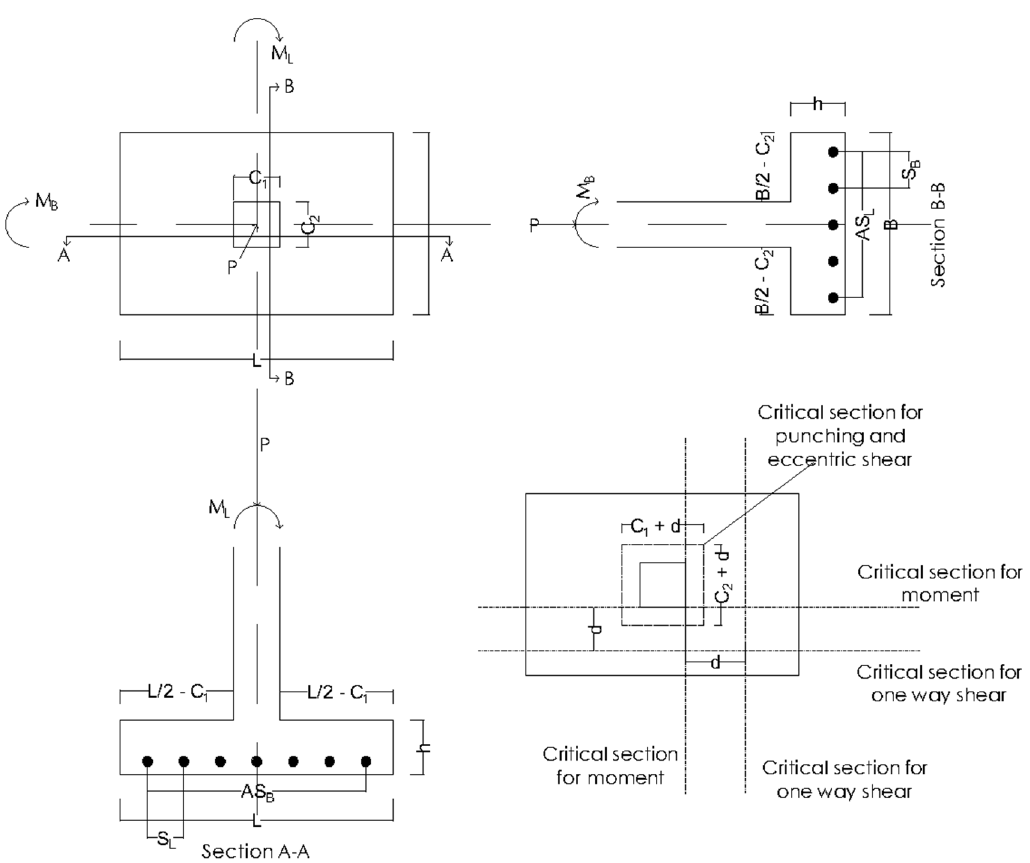
Figure 1. Reinforced concrete isolated footing sections and critical sections for moments, one way, punching and eccentric shear.